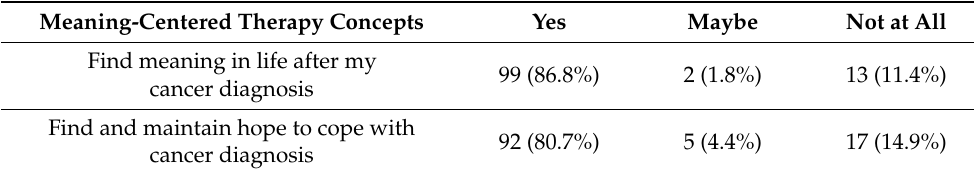
Table 3. Meaning-centered psychotherapy concepts: Dyads.